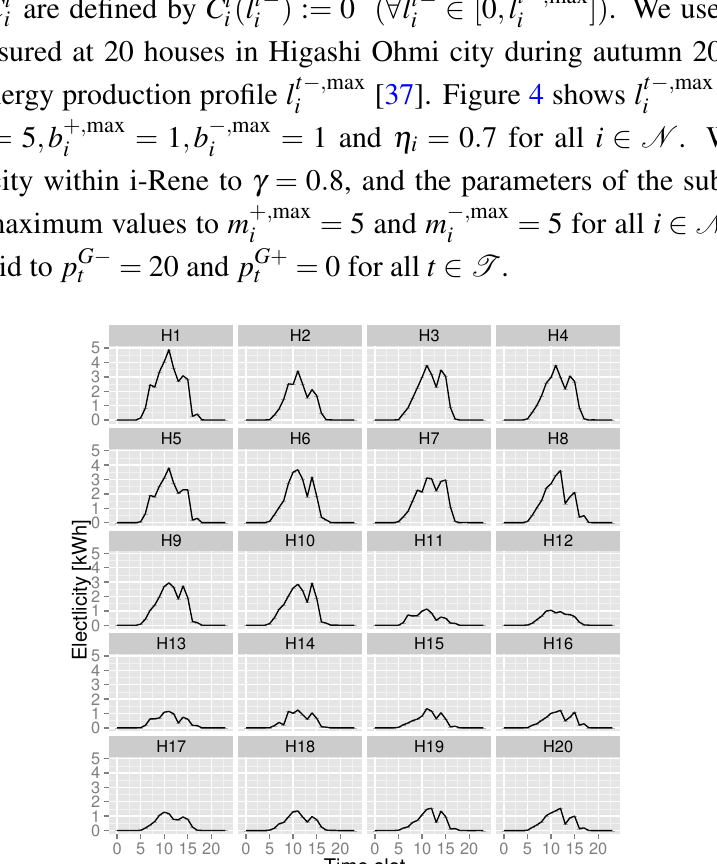
by 20 prosumers’ PV i